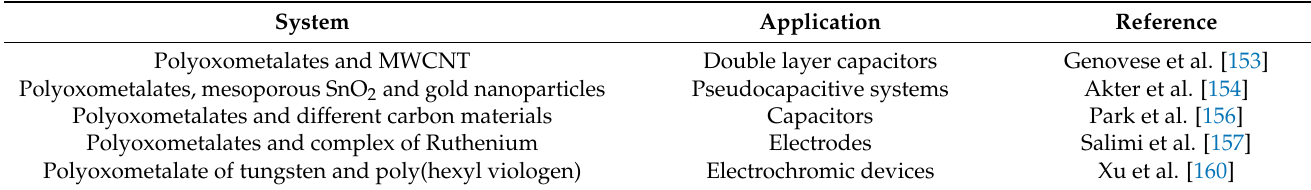
Table 6. Examples of LbL structures containing polyoxometalates and their potential applications. System